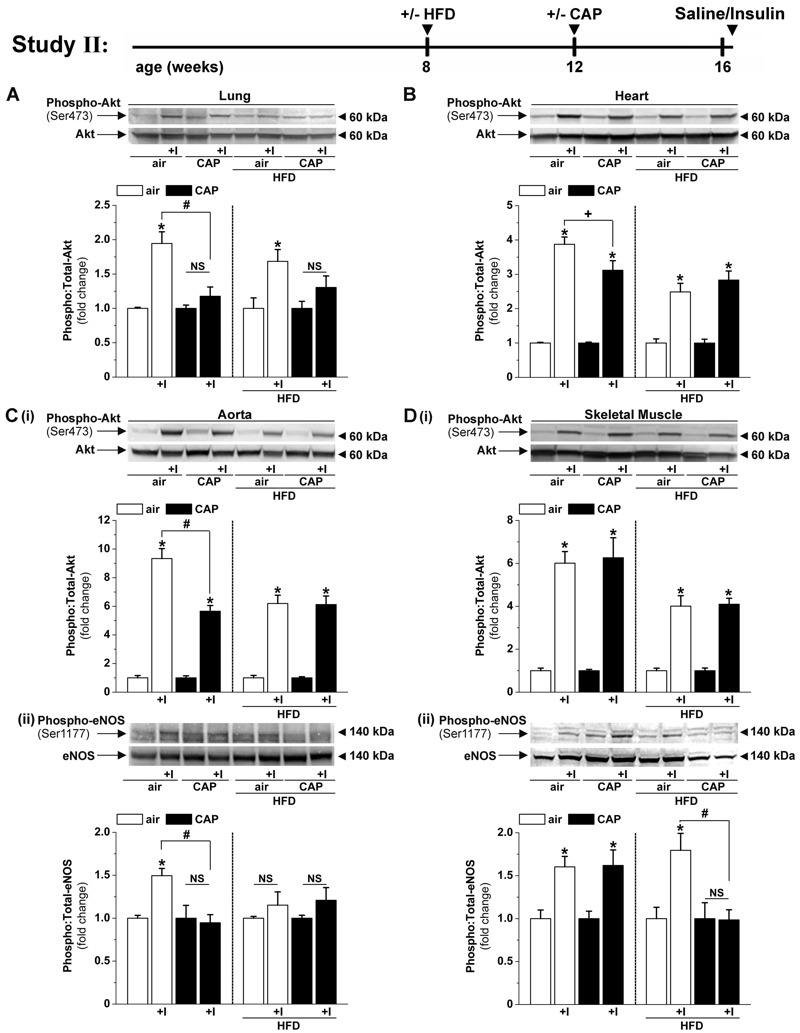
Effects of concentrated fine particulate matter (CAP) exposure on organ-specific insulin sensitivity. Western blot analysis of Akt phosphorylation in lung (A) and heart (B) and phosphorylation of Akt (i) and eNOS (ii) in aorta (C) and skeletal muscle (D) in mice injected with saline or insulin (1.5 U/kg). Mice fed control diet (10% kcal fat) or placed on a high-fat diet (HFD, 60% kcal fat) were exposed to air or CAP for 30 days (Study II). Data are the mean ± SE normalized to controls. NS, not significant. *p < 0.05 saline vs. insulin; #
p < 0.05, +
p < 0.1 air versus CAP; n = 4.